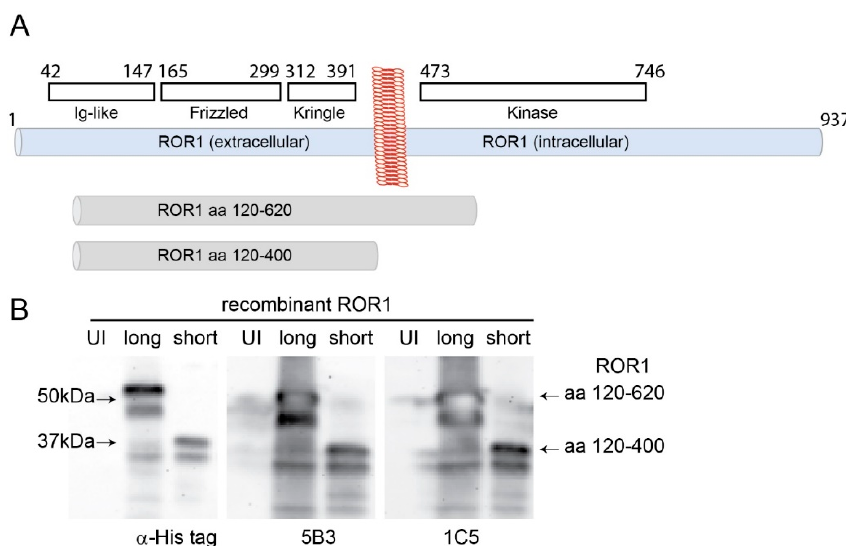
Figure 2. Generation monoclonal antibodies against ROR1. ( A ) Schematic representation of the domains of ROR1. Recombinant protein of ROR1 (aa 120–620) was used for the immunization. Recombinant protein of ROR1 (aa 120–400) was generated with site-directed mutagenesis and represents the extracellular part of ROR1 protein. ( B ) Western blot analysis of ROR1 antibodies (5B3 and 1C5) and His-tag antibody. Both 5B3 and 1C5 antibodies detected the both full and short length recombinant proteins of ROR1.